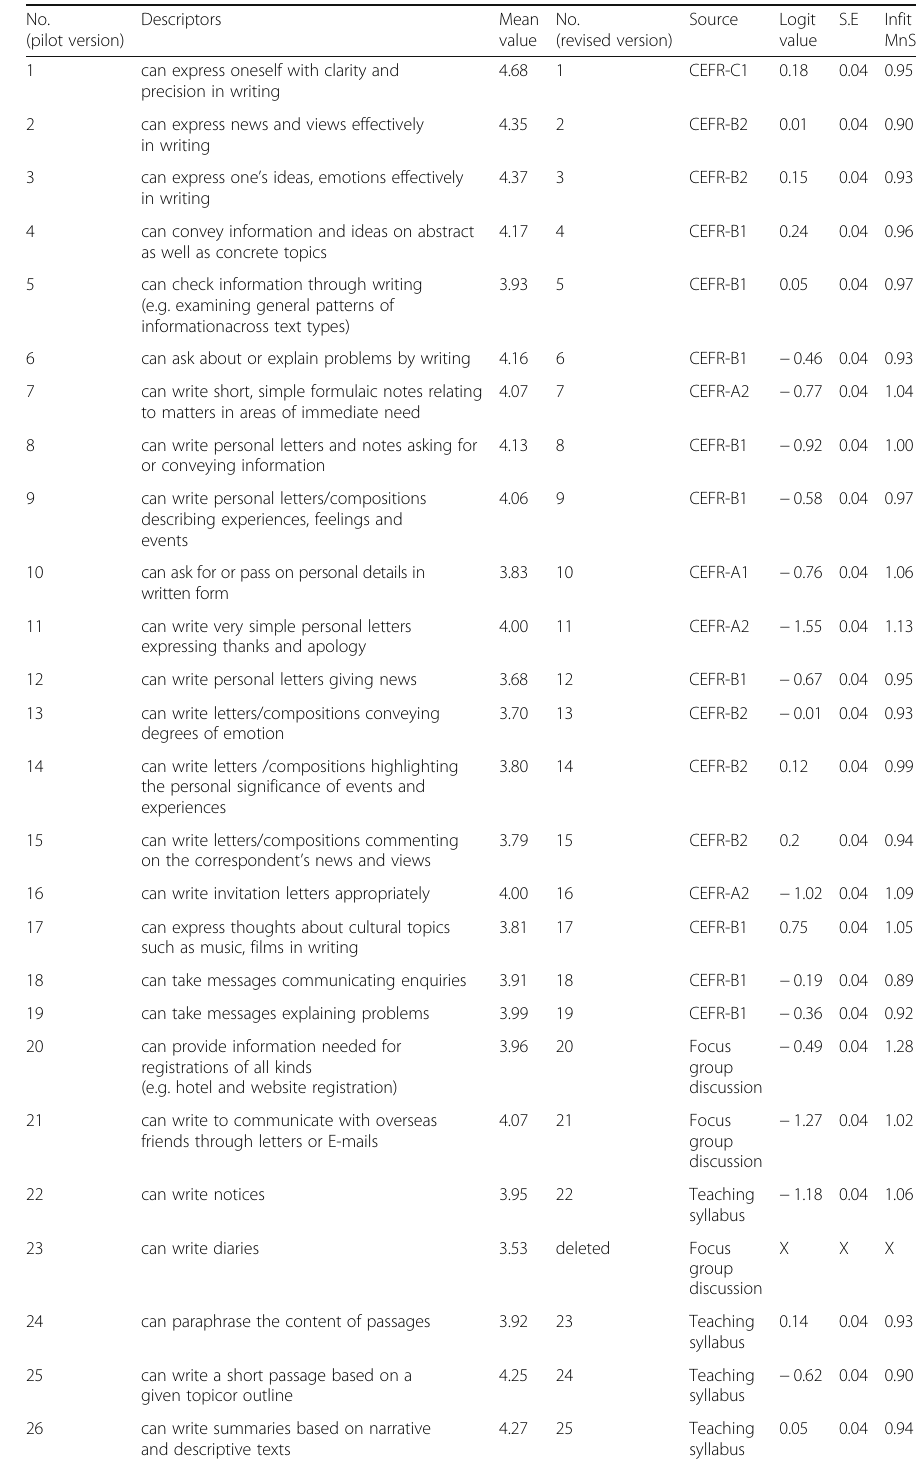
Table 2 Mean value, source, logit value, S.E., and Infit MnSq. of the descriptors (pilot version and revised